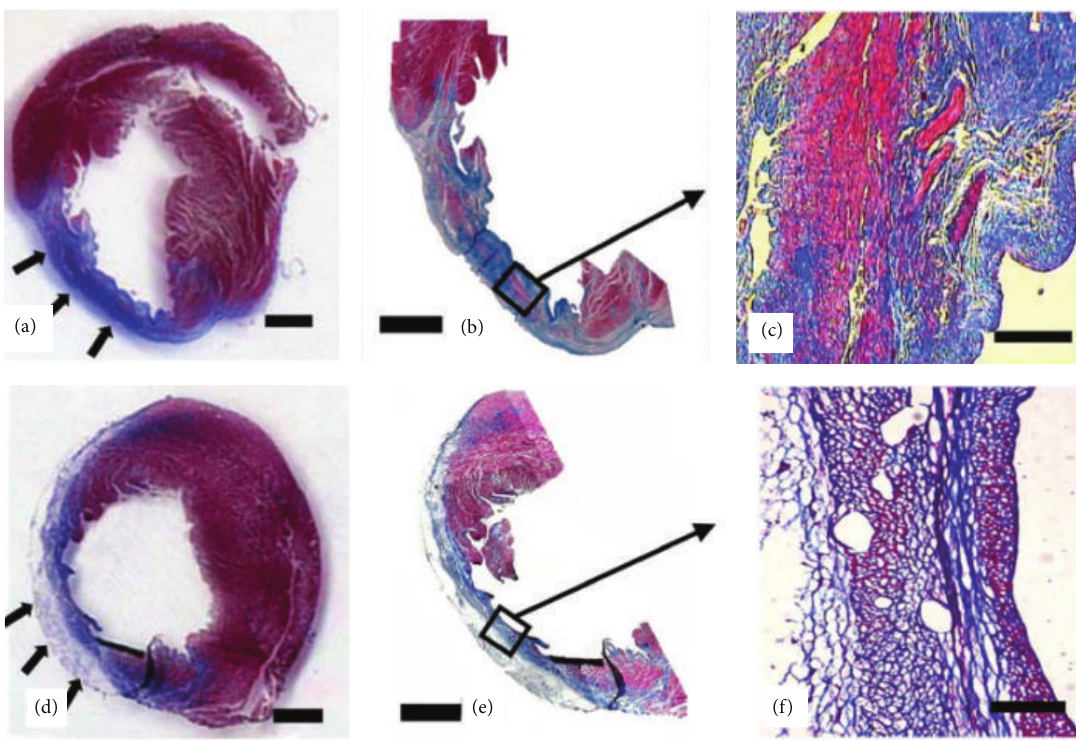
Figure 5: Masson’s trichrome staining of infarction site after eight weeks for treatment with bone marrow mononuclear cells delivered with ((a), (b), and (c)) and without ((d), (e), and (f)) fibrin gel. The infarction size of treatment with fibrin gel (arrows) is smaller than the treatment without fibrin gel. Treatment with cell-fibrin gel mixture demonstrated a larger amount of viable tissue (red) and a smaller amount of fibrous tissue (blue) when compared to the direct injection of cells without fibrin gel. Scale bar indicates 2mm in (a), (b), (d), and (e) and 100 𝜇 m in (c) and (f) [47].